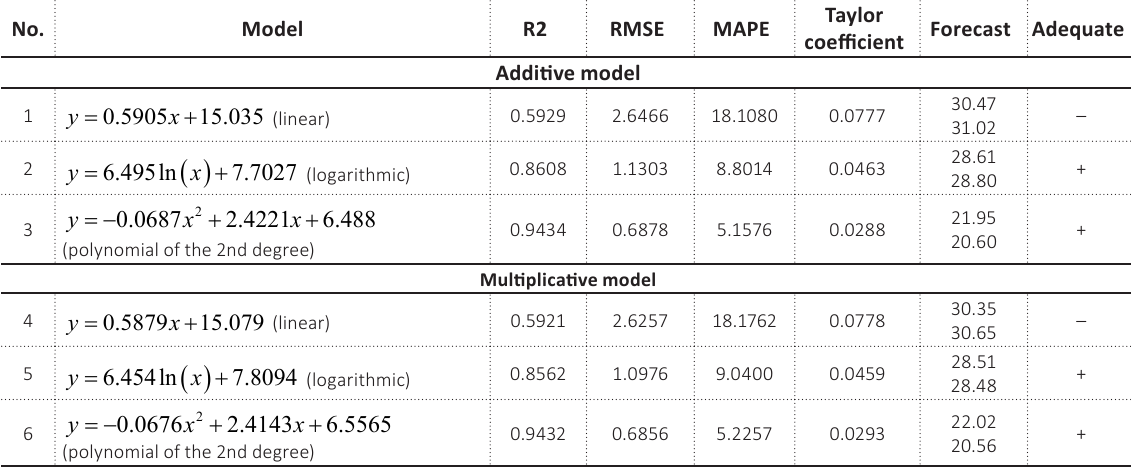
Table 4. Results for the lag structure test of the VAR-model lag LL